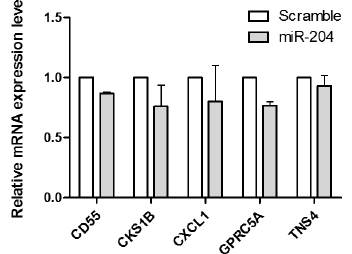
Figure 5. QRT-PCR validation of five target genes CD55 , CKS1B , CXCL1 , GPRC5A and TNS4 of miR-204 common in RNA-seq analysis and prediction.